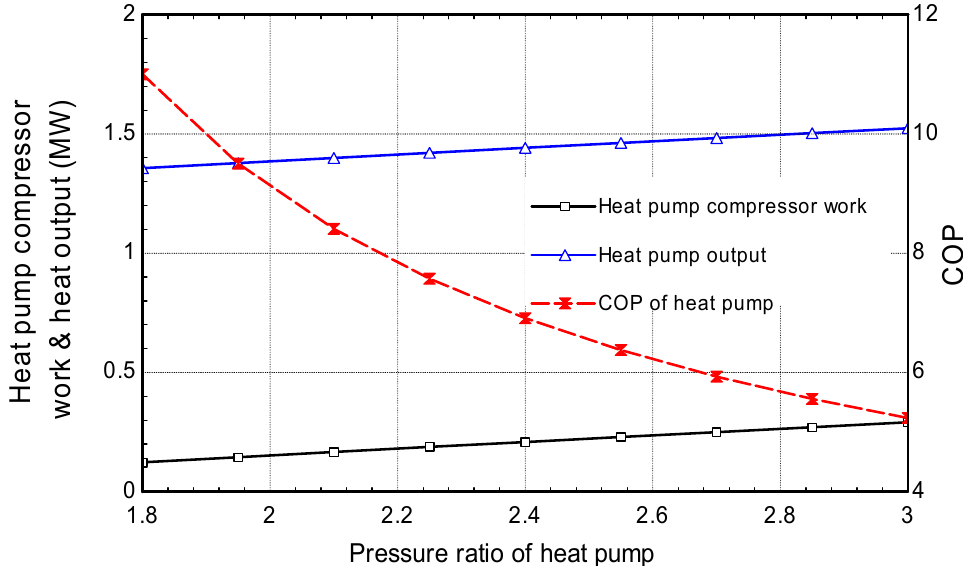
Figure 5. Impact of varying the pressure ratio of the heat pump on the compressor work of the heat pump, the heat pump output, and the COP of the heat pump.